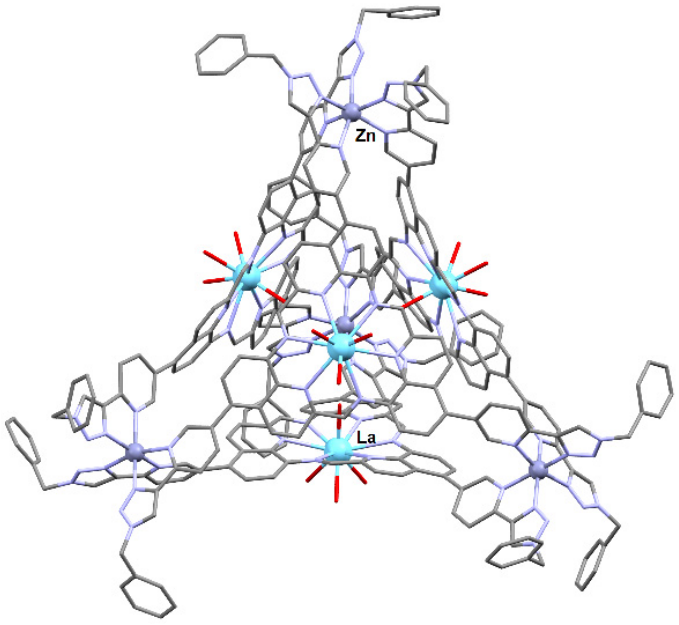
Figure 14. Crystal structure of the cationic cage 21 . Hydrogen atoms and perchlorate anions (which are present both inside and outside the cage cavity) are not shown